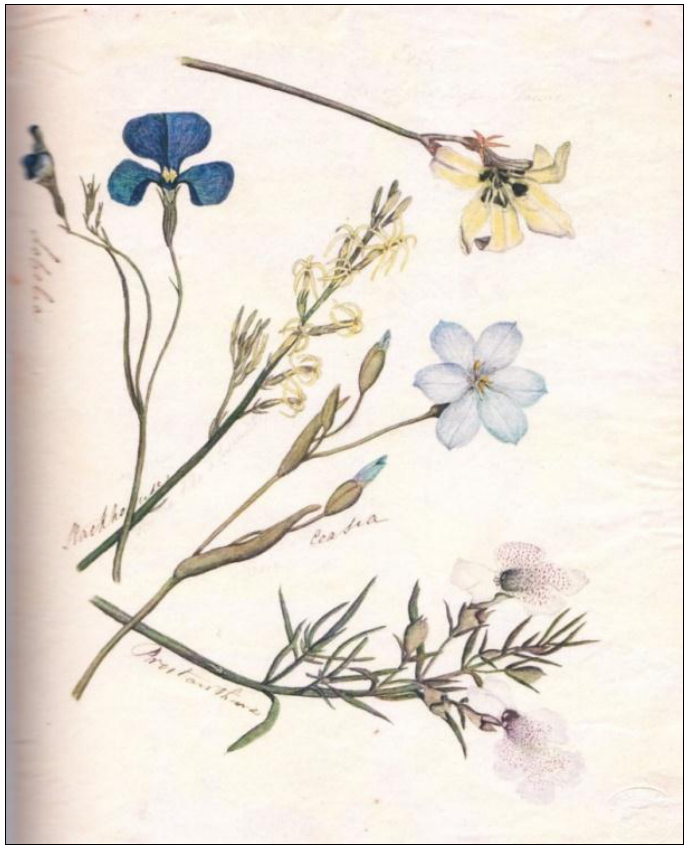
Figure 4. Plate XIX of Georgiana Leake’s Wildflower Album